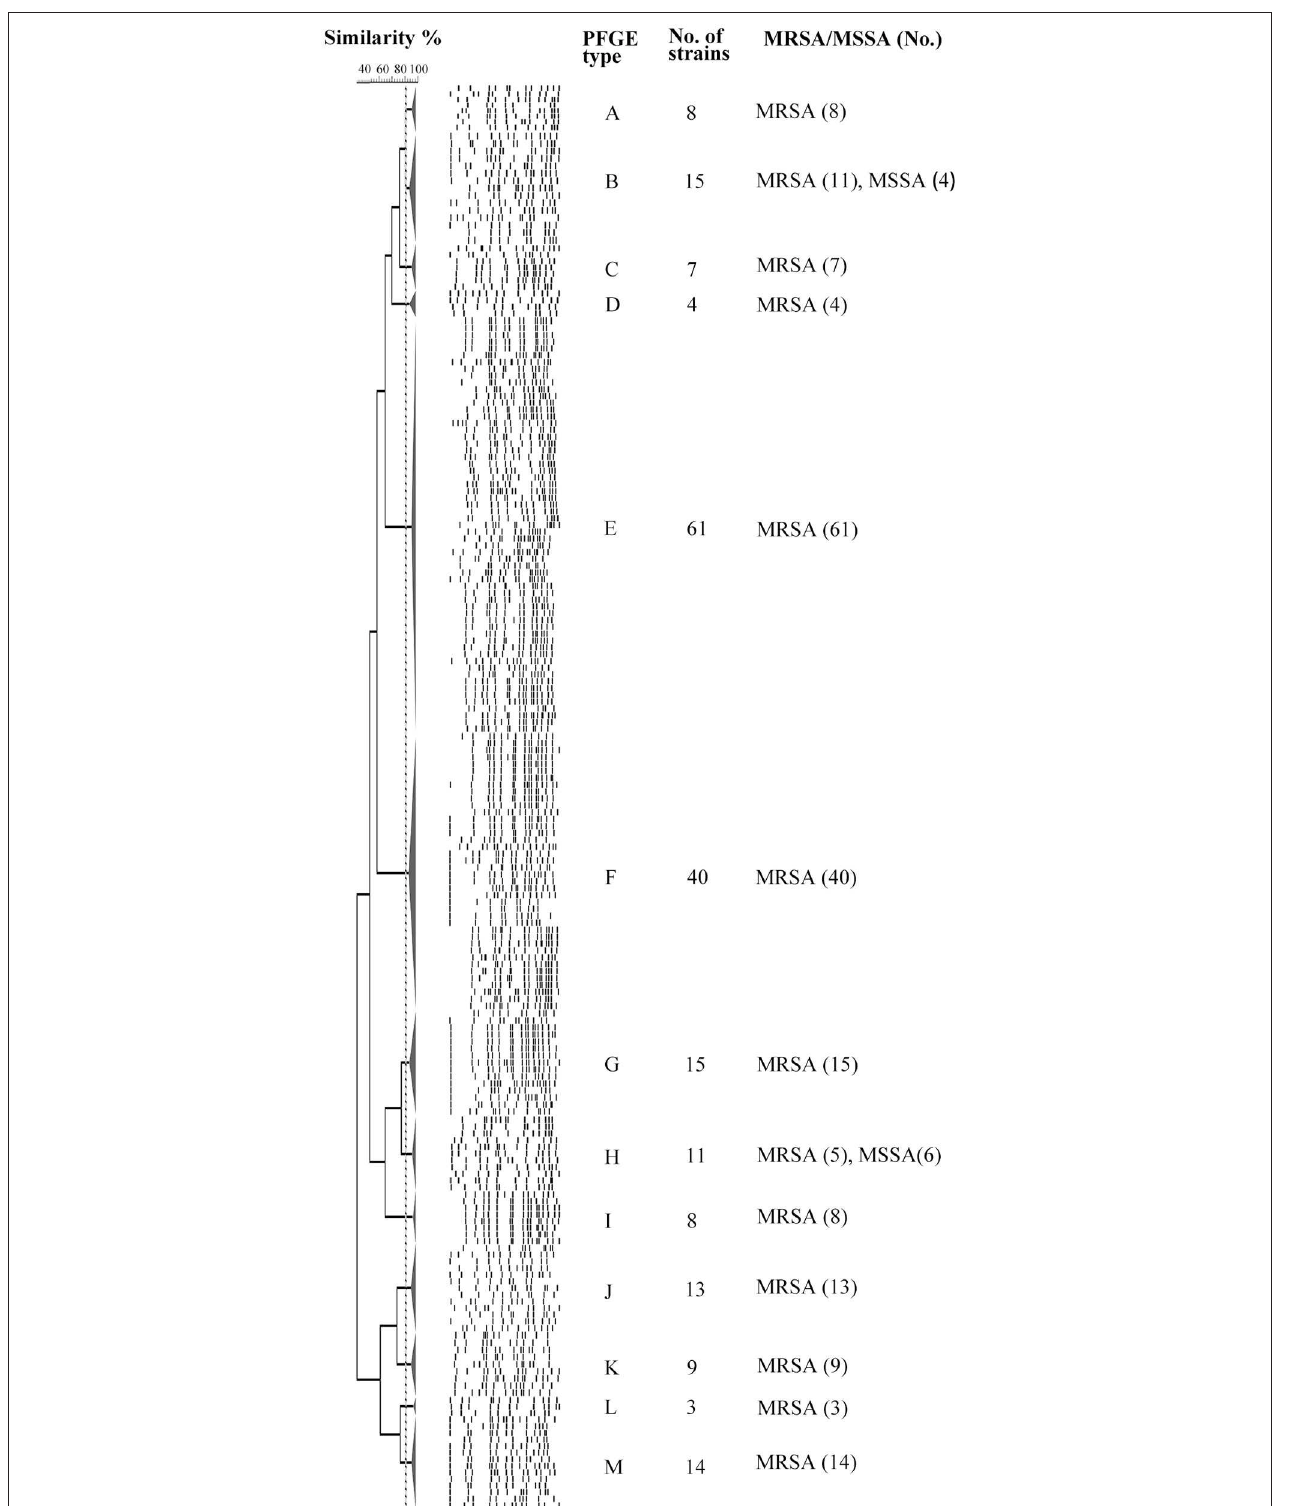
FIGURE 1 | PFGE analysis of 208 tst gene positive S. aureus isolates digested with SmaI. This dendrogram shows the 208 S. aureus strains were clustered into 13 genomic groups (A-M).